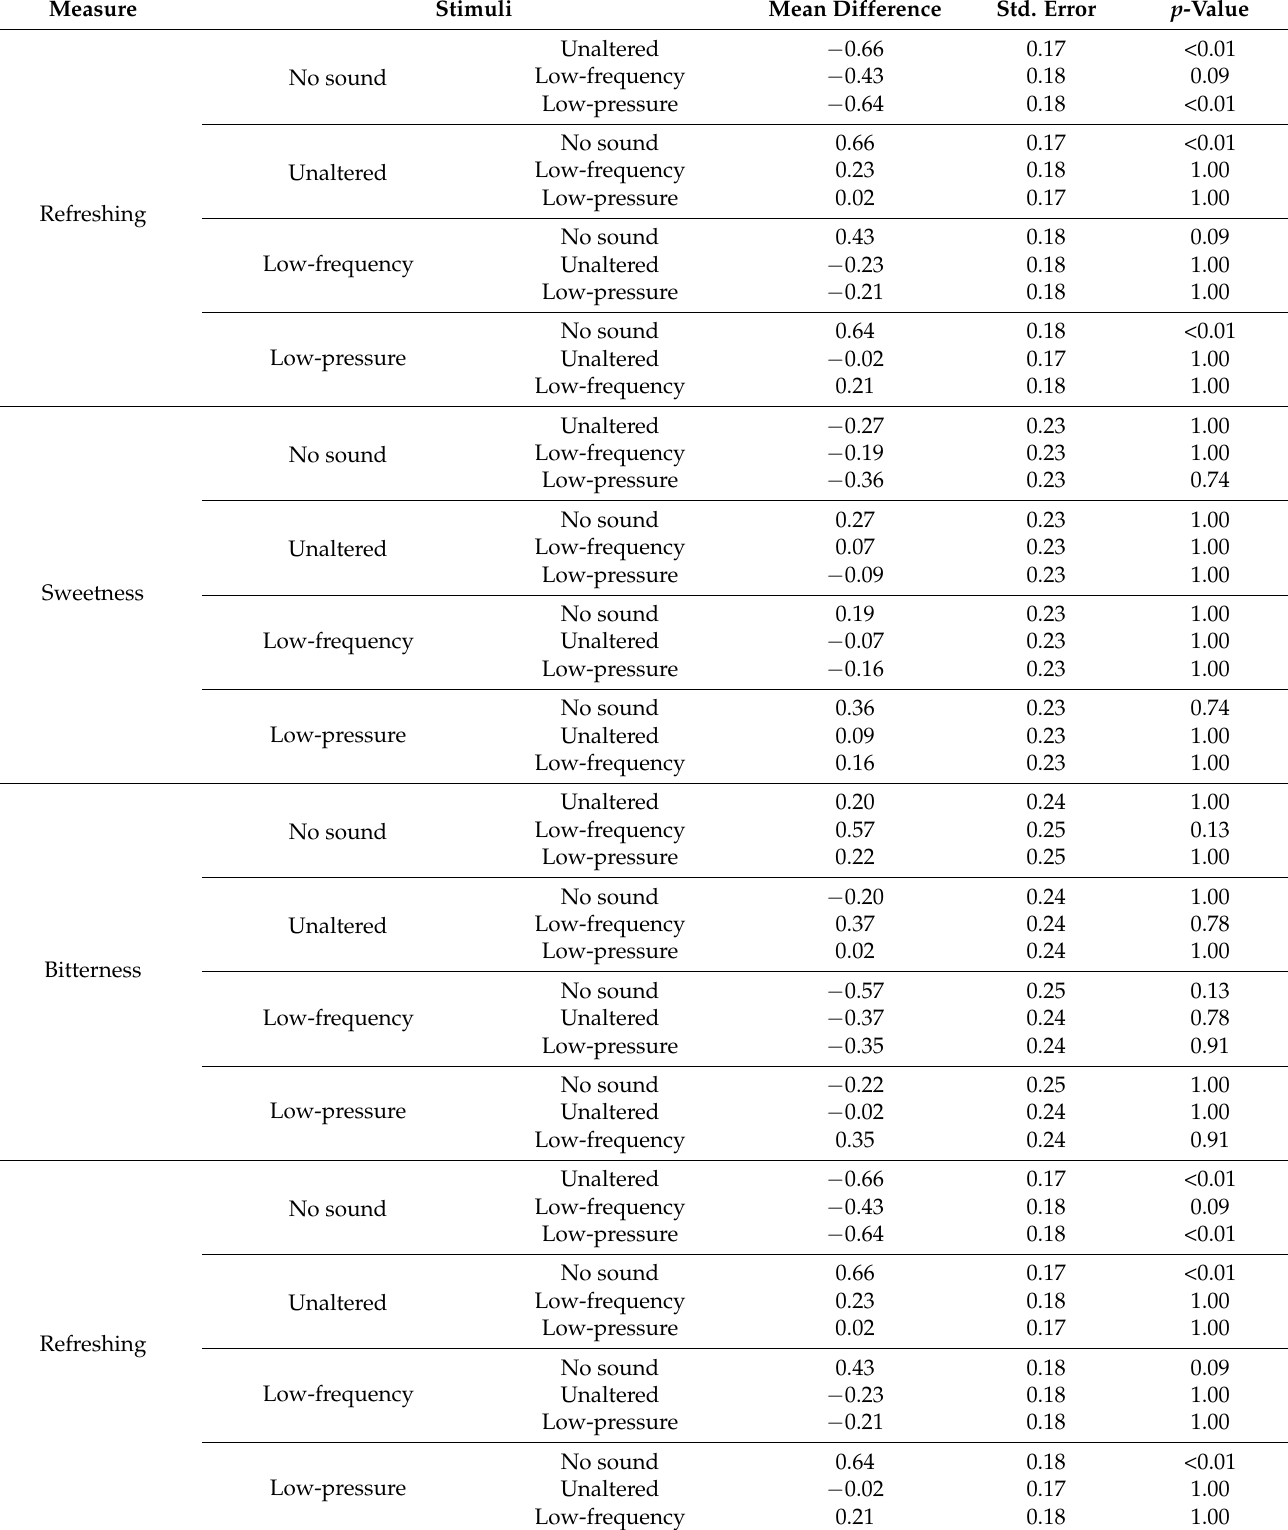
Table A6. Summary of the results of the pairwise comparisons of auditory conditions on each sensory expectation in Experiment